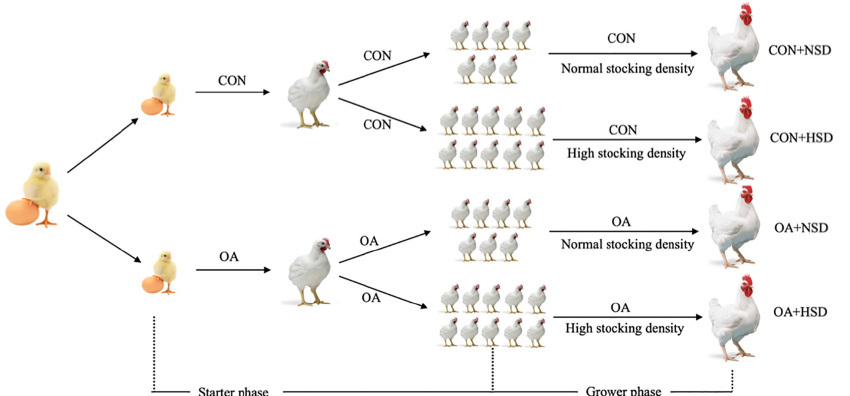
Figure 1. Schematic drawing of the experimental design. In the starter phase, broilers were randomly divided into two groups: broilers that drank normal water without any organic acids (CON) and organic acids in drinking water (OA). In the grower phase, each group in the starter phase was randomly divided at two stocking densities. The factorial management of organic acids and stocking density results in the following four treatment combinations: (1) CON+NSD: broilers that drank normal water under normal stocking density; (2) CON+HSD: broilers that drank normal water under high stocking density; (3) OA+NSD: broilers that drank OA-supplemented water under normal stocking density; (4) OA+HSD: broilers that drank OA-supplemented water under high stocking density.